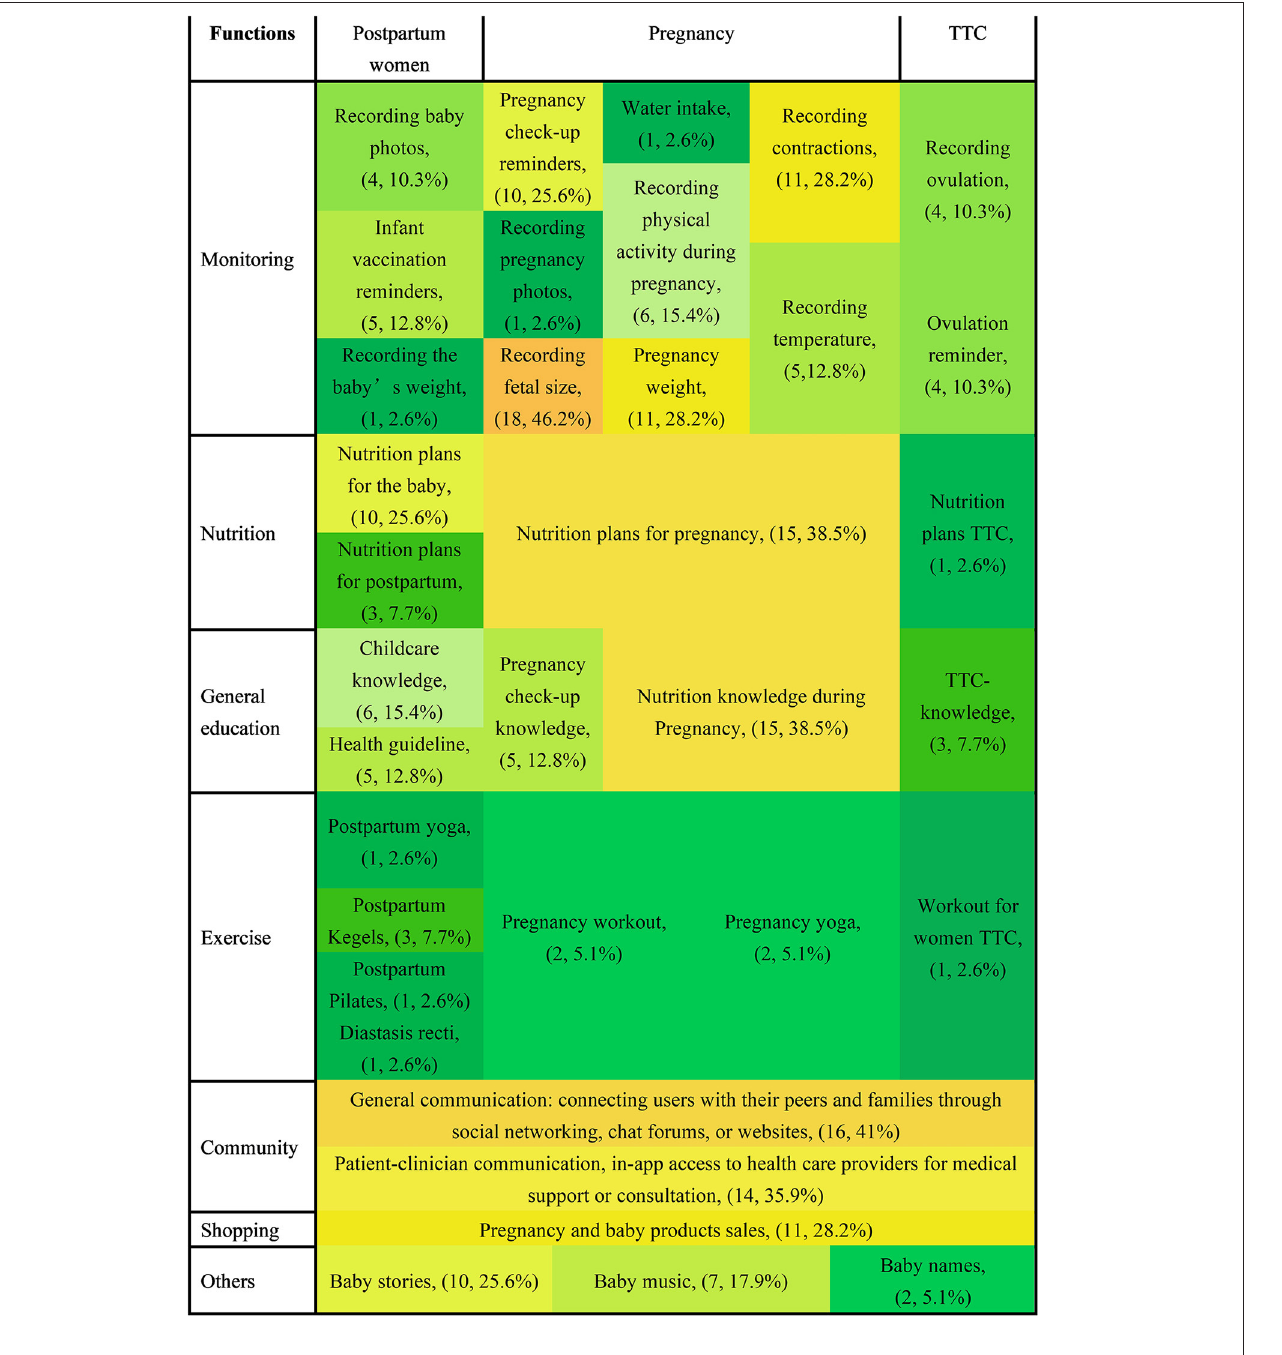
and combined with professional medical advice; and (3) some Chinese and US apps were suspected of stealing users’ personal information. These findings do not support our hypothesis and highlight key areas for improvement of apps targeted at pregnant and postpartum